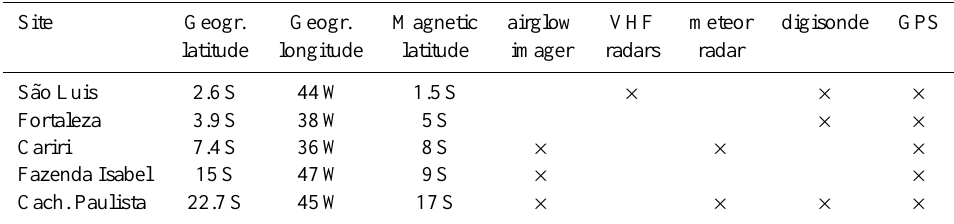
Table 1. Instrumentation at the fixed INPE and temporary SpreadFEx measurements sites employed for our experiment. GPS were also available at ∼ 20 other locations in Brazil.